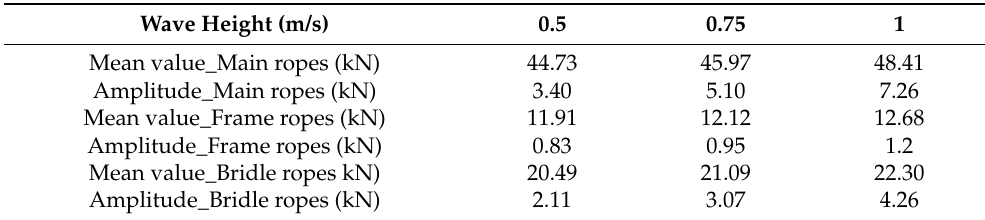
Table 5. Mean values and amplitudes of the maximum mooring forces in different parts of the mooring system under different wave